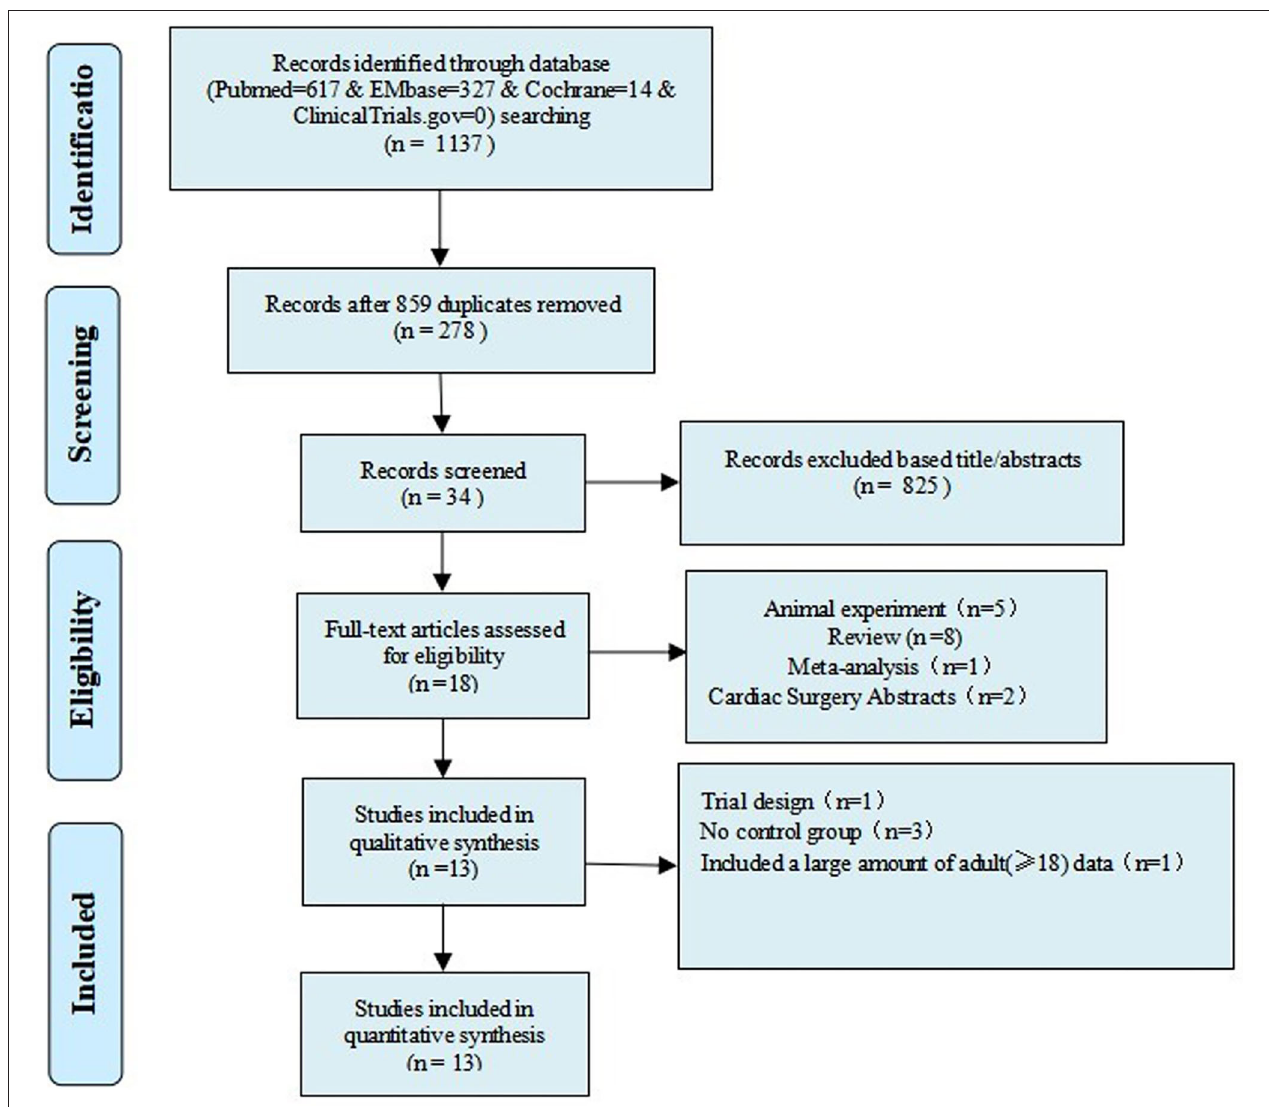
FIGURE 1 | Flow chart of the selection process for studies included in the systematic review and